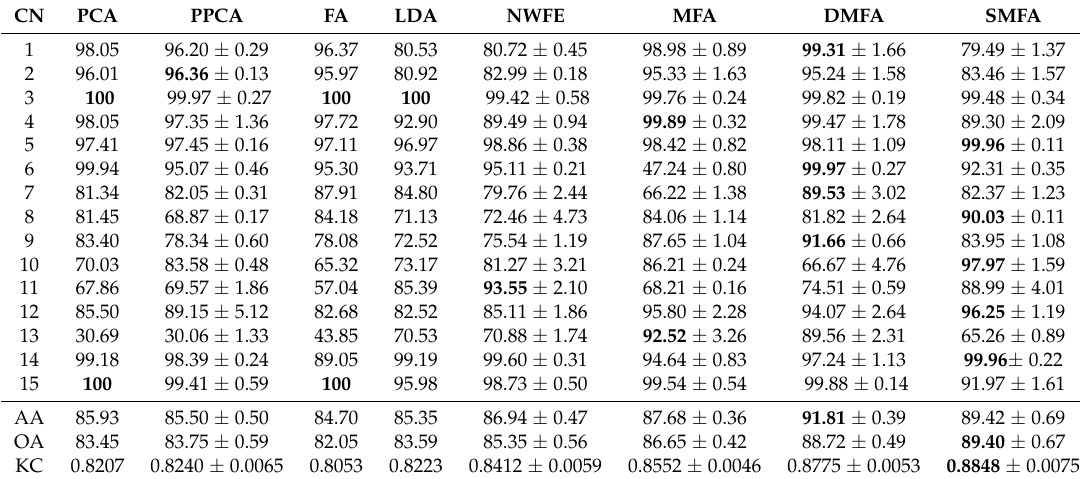
Table 7. The classification results (%) of different DR methods on the Houston dataset, the best results are in bold typeface. The row of each class number (CN) is the mean accuracy ± standard deviation based on ten